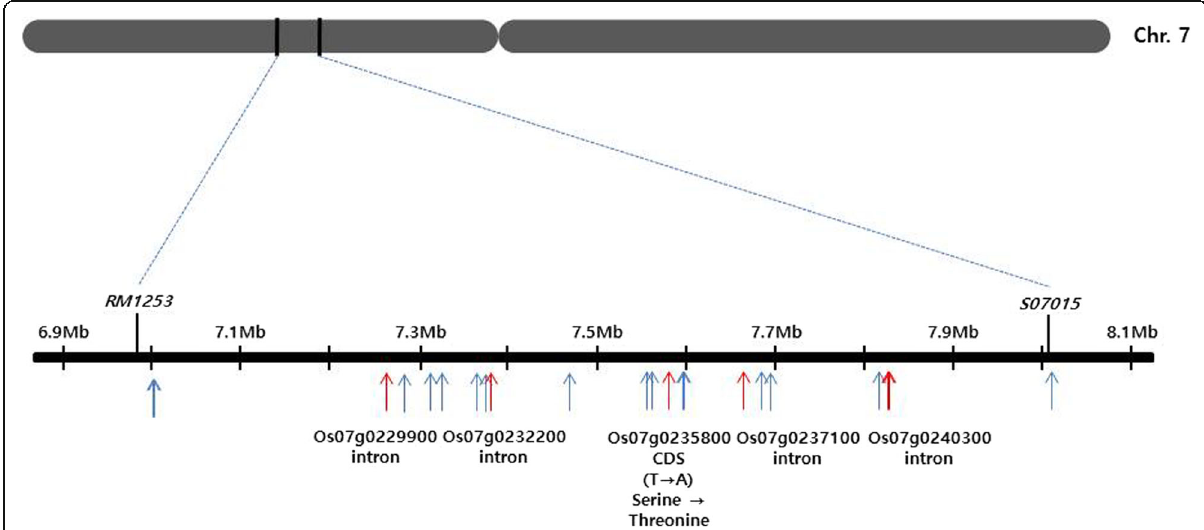
Fig. 2 SNPs found in the SUI4 gene region on chromosome 7. Twenty-two SNPs were identified between sui4 and Dongjin in the 1.1- Mb interval region ( RM1253-S07015 ) mapped in our previous study (Ji et al. 2014). Detailed information was shown in Additional file 1: Table S1. Red arrows indicate the positions of SNPs in genic regions while blue arrows indicate the positions of SNPs in intergenic